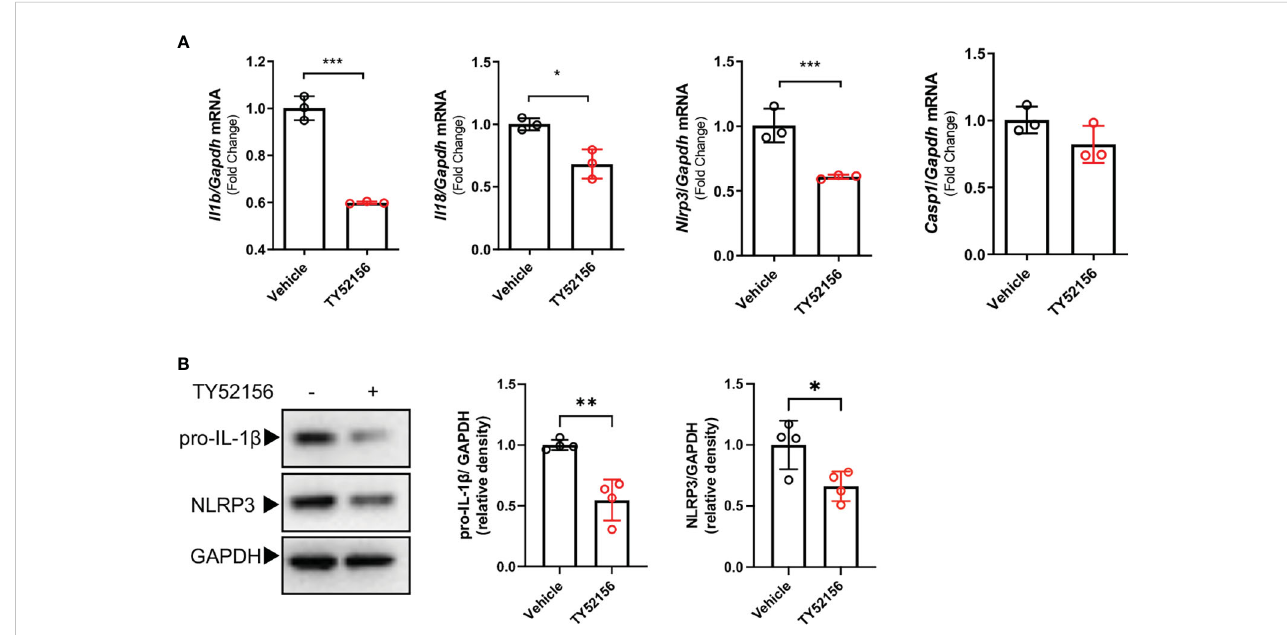
FIGURE 3 Inhibition of S1PR3 suppresses the LPS priming signal in BMDMs. (A-B) BMDMs treated with LPS (1 m g/mL) for 4h with or without TY52156 (10 m M). The mRNA expressions of IL-1 b , IL-18, NLRP3, and caspase-1 were measured by RT-qPCR (A) . The protein expression of pro-IL-1 b and NLRP3 (B) were measured by Western blot (n=3). Values are presented as mean ± SD. *p < 0.05, **p < 0.01, ***p < 0.001, two-tailed